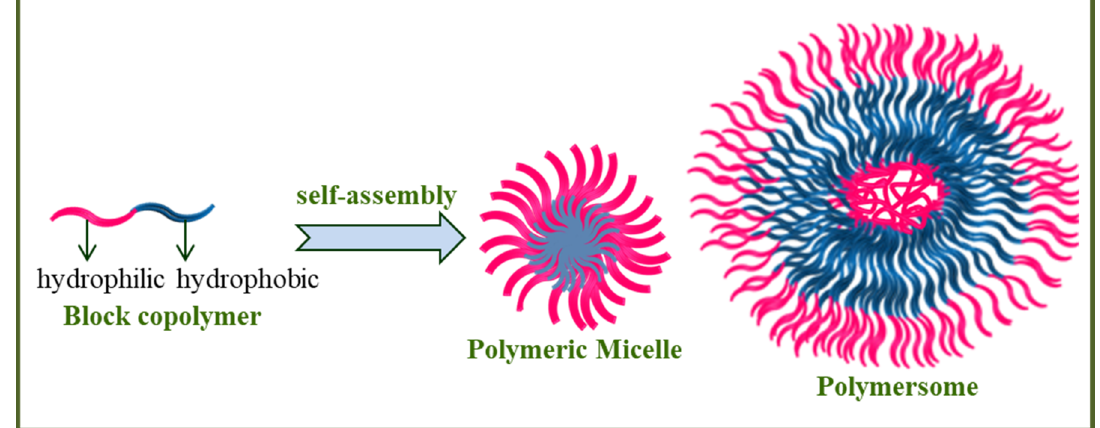
Figure 5. Self-association of amphiphilic block copolymer as polymer micelle or polymersomes in aqueous solution.